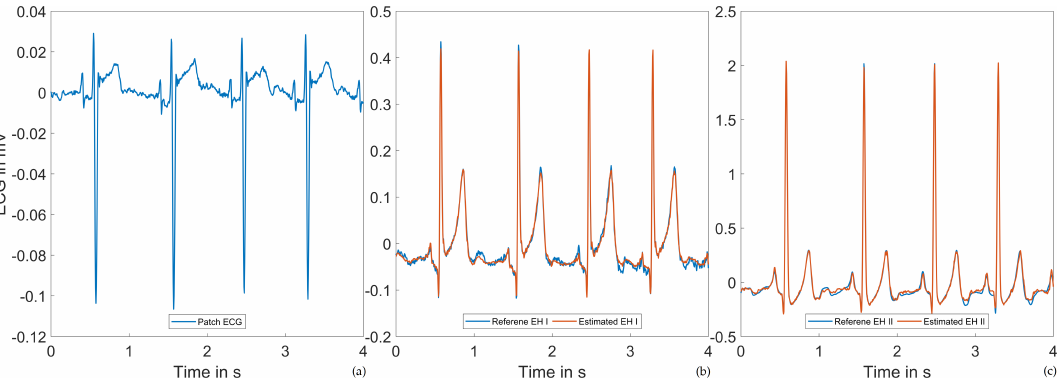
Figure 10. Example ECG signals of Subject 2 in the supine position: ( a ) Patch ECG. A high intersubject variability of the patch ECG lead can be observed when compared to Figure 9a. ( b ) Reference and estimated Einthoven I ECGs. ( c ) Reference and estimated Einthoven II